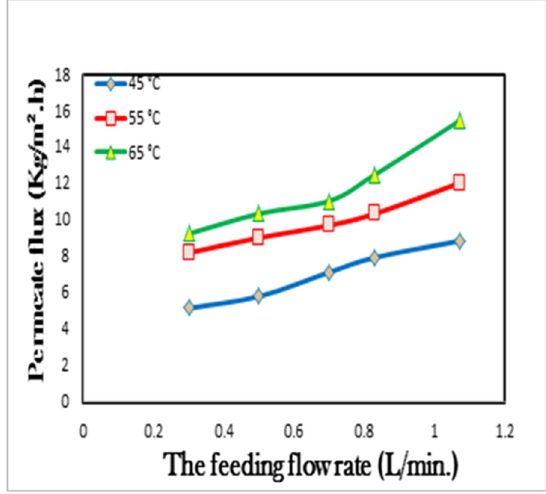
Fig. 7. Effect of feed concentration on the permeation flux for solution at 60 °C feed